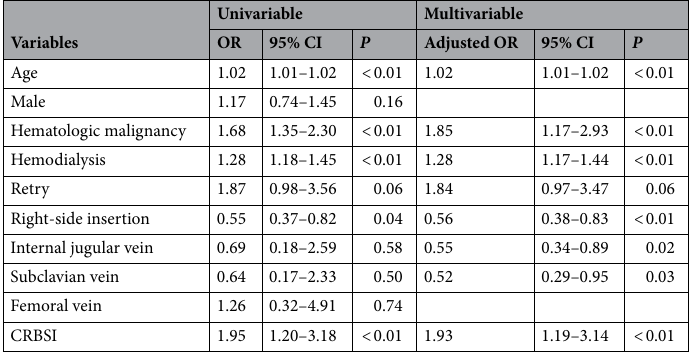
Table 3. Univariate and multivariate logistic regression model for predicting in-hospital mortality. OR odds ratio, CI confidence interval, CRBSI central line-related blood-stream